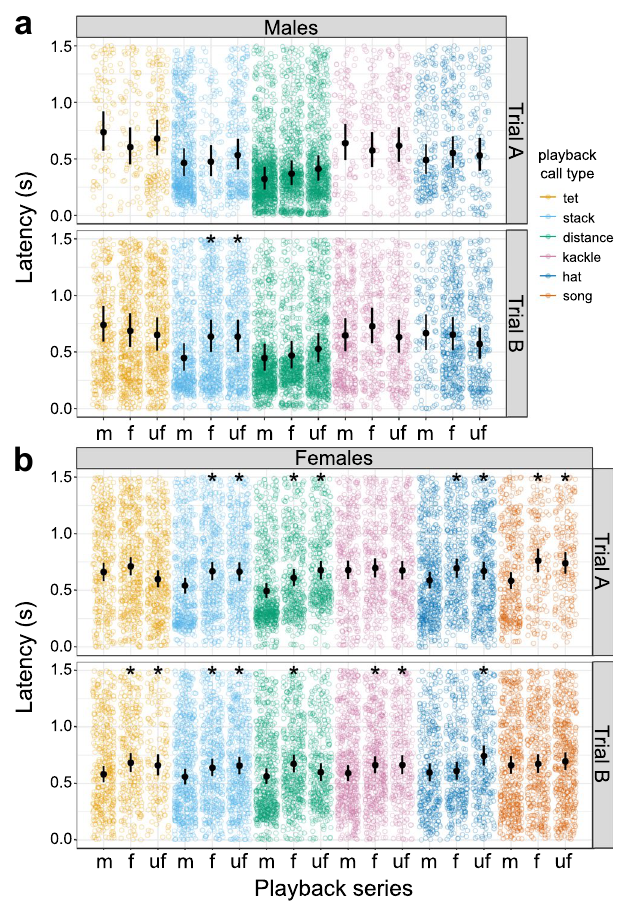
Figure 1. Latency during playback. Latency to the first answering call for different playback series (analysed time interval: 0–1.5 s after the onset of the playback stimulus). Colours represent the type of playback call broadcast; dots indicate individual calls (raw data). Familiarity categories: m = mate of the focal bird; f = familiar individual; uf = unfamiliar individual. For males ( a ) and females ( b ) in both trials the computed 95% credible intervals (error bars) as well as the fitted value (black symbols) are shown. Significant differences between mate and the other familiarity categories are marked by black